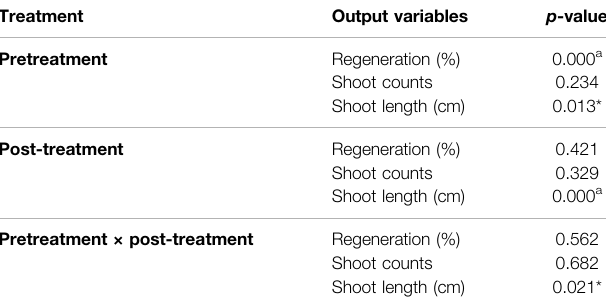
TABLE 1 | Analysis of variance of output variables of common bean.